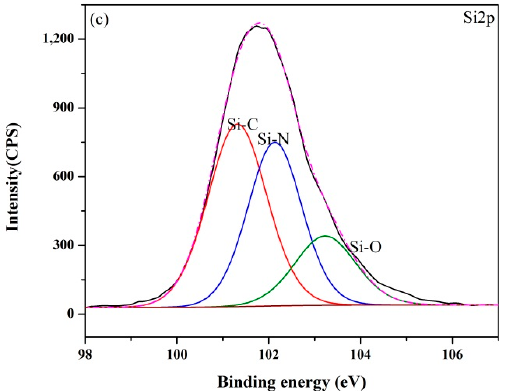
Figure 6. XPS core-level spectra of sample A synthesized at 1550 °C: ( a ) C1s, ( b ) N1s and ( c ) Si2p.